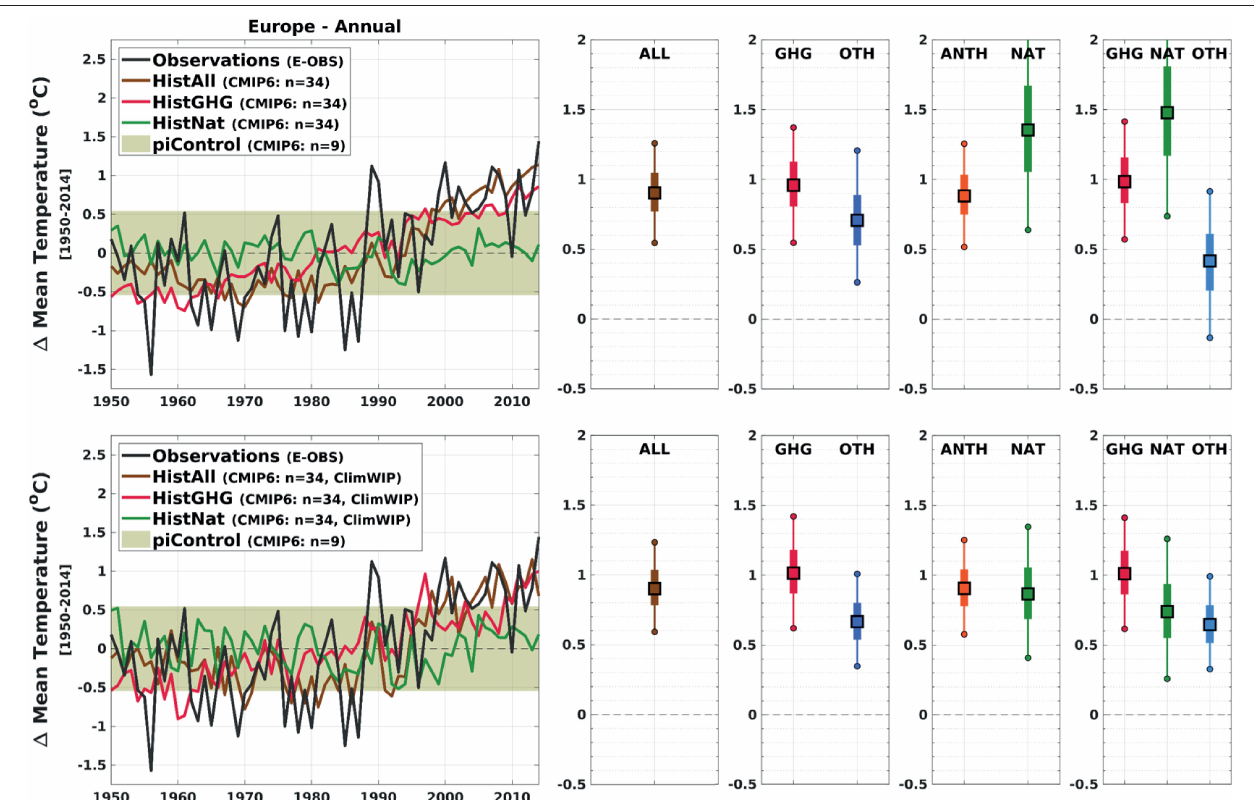
FIGURE 4 | Annual time series (left panels) of European surface air temperature anomalies (relative to 1950–2014) from observations (E-OBS v19, black line) and CMIP6 historical simulations (all forcings, brown line; GHG-only forcing, red line; and NAT-only forcing, green line). We display the multi-model mean of ensemble means from nine models, with the shaded region denoting the multi-model mean variability ( ± 1 standard deviation) of the associated preindustrial Control simulations. The scaling factors (right panels) are derived by regression of the CMIP6 model fingerprints on the observations and indicate to what extent the multi-model mean fingerprint needs to be scaled to best match observations. Results show the 1-signal (ALL), two-signal (GHG & OTH; ANTH & NAT), and three-signal (GHG, NAT & OTH) scaling factors. The upper panels display the time-series fingerprints and associated scaling factors using an equal-weighted multi-model mean; the lower panels use ClimWIP performance weighting to weight the multi-model mean fingerprints for deriving the scaling factors. Confidence intervals show the 5th − 95th (thin bars) and 25th − 75th (thicker bars) percentile ranges of the resulting scaling